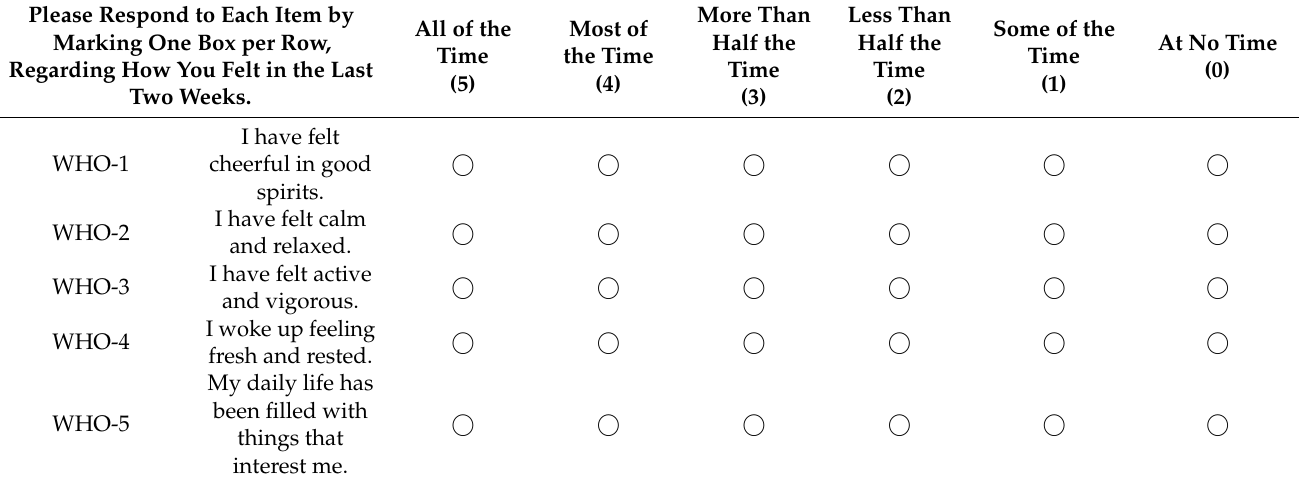
Table 1. WHO-Five Well-Being Index